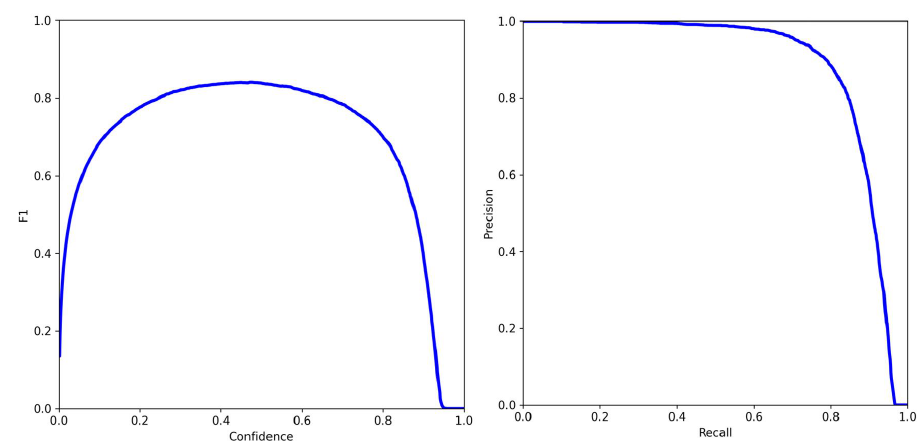
Figure 19. The relationship between loss, precision, recall, mAP, and epoch.